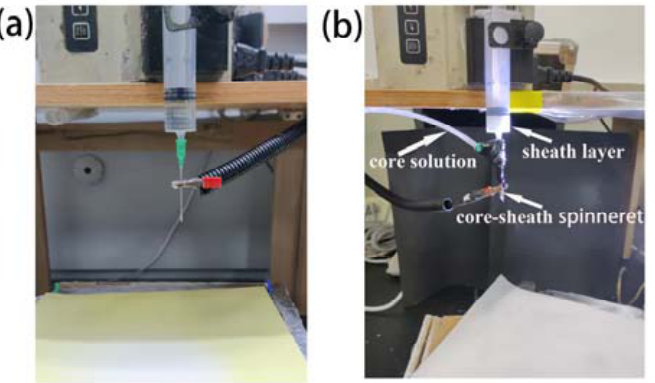
Figure 2. Electrospinning setup of ( a ) uniaxial electrospinning and ( b ) coaxial electrospinning. The electrospinning process of coaxial electrospinning is a bit different from uniaxial electrospinning. The core solution and sheath solution are driven by the pump; then the two solutions meet at the end of homemade coaxial spinneret. Under the surface tension and electric field force, an inner and outer layer Taylor cone was formed. In the electric field force, the jet was extruded from the Taylor cone. Then core-sheath fibers were collected on the collector. The prepared core and sheath solutions were pumped separately. The core layer was NPs-PVDF, which functioned as the outer layer, and the PCL solution acted as the inner layer. The two solutions were pumped at a different speed from the electrospinning process. PCL was pushed at 1 mL/h, and the NPs-PVDF solution at 1.5 mL/h. The tip-to- collector distance was 15 cm, and the applied voltage was set at 12 kV. In the Figure 2b, coaxial electrospinning setups are